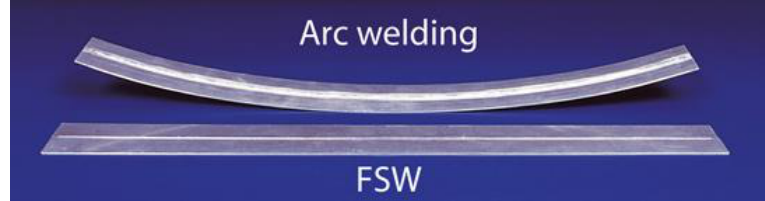
Figure 1. Welding deformation of arc welding and friction stir welding (FSW).